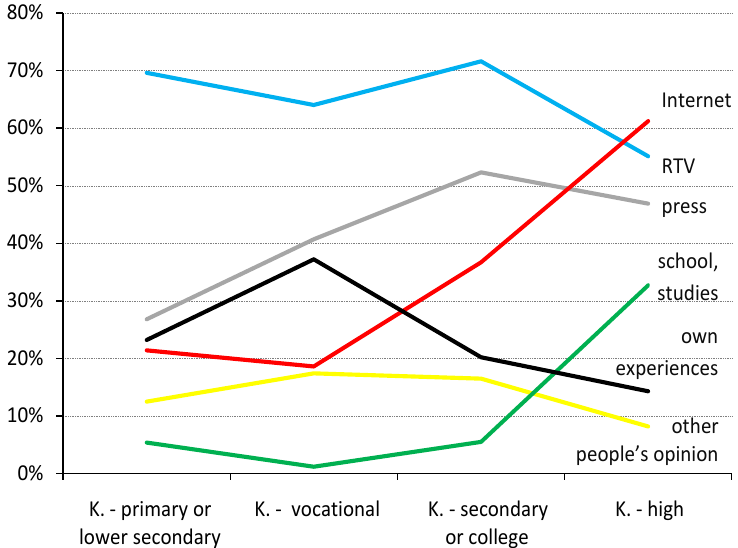
Fig. 6. What is your main source of information about resources excavation? Please indicate three from among the given ones. The inhabitants of the Kleszczów community (n = 300) divided by education level (Source: Telephone interviewing